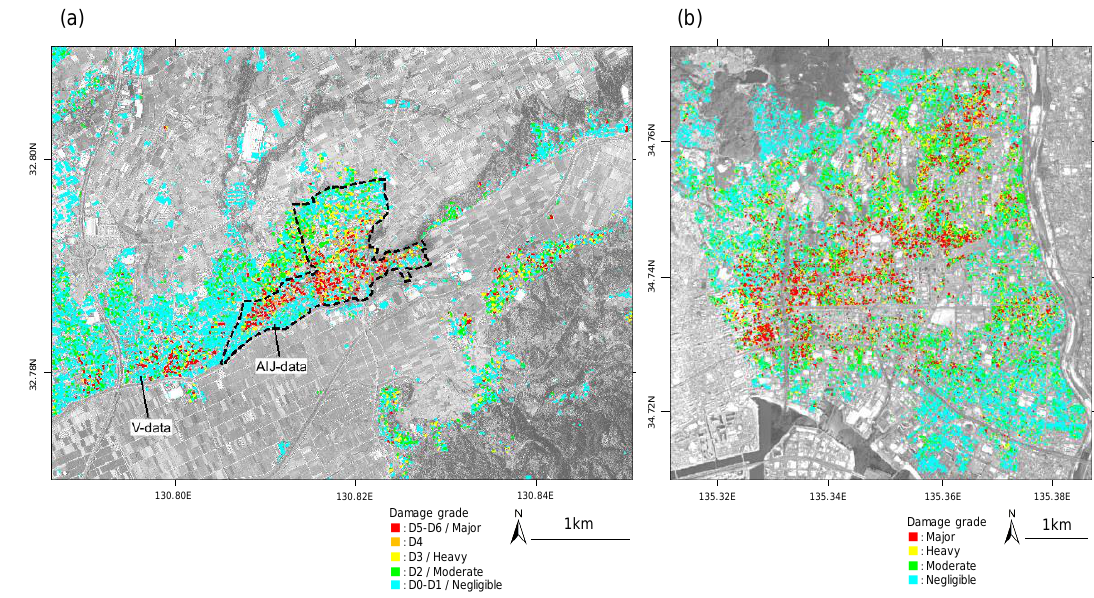
Figure 3. ( a ) Damage distribution of AIJ- and V-data in Mathiki town affected by the 2016 Kumamoto earthquake. ( b ) Damage distribution of BRI-data in Nishinomiya city affected by the 1995 Kobe earthquake.